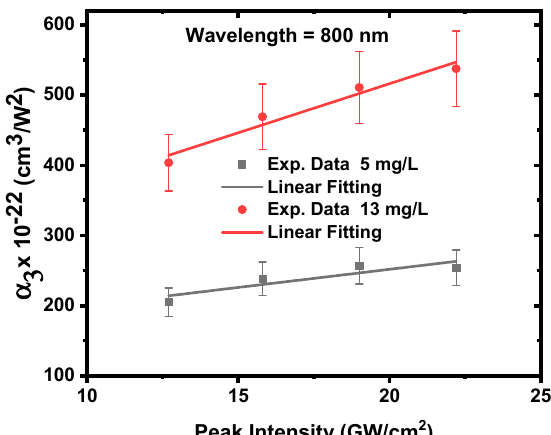
Figure 7. The 3PA coefficient of ZnONPs colloids as a function of the incident peak intensity at a constant excitation wavelength of 800 nm.